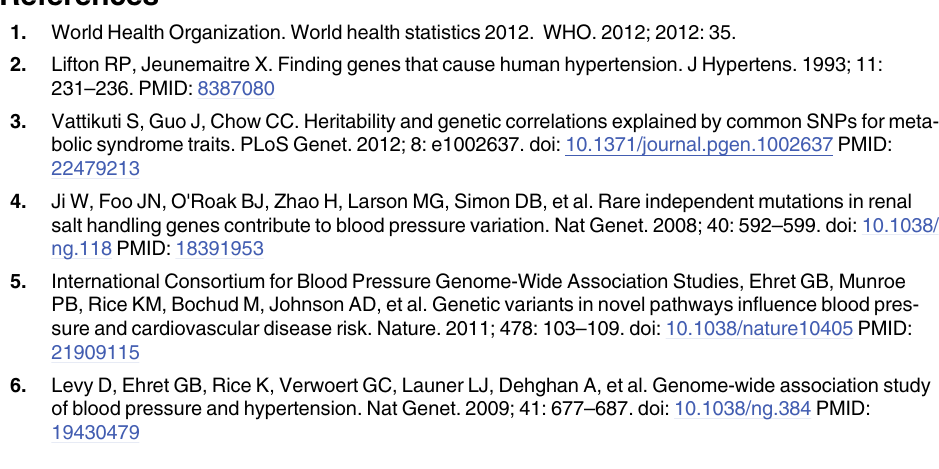
S1 Table. Proportion of the genetic variance explained by each chromosome and the whole genome using 8,901 EA individuals. S2 Table. Proportion of the genetic variance explained by each chromosome and the whole genome using 2,860 AA individuals. S3 Table. Proportion of the genetic variance explained by each chromosome and the whole genome using 6,914 EA unrelated individuals. S4 Table. Proportion of the genetic variance explained by each chromosome and the whole genome using 1,763 AA unrelated individuals. S5 Table. Estimates of the SBP and DBP heritability from classical family and twin